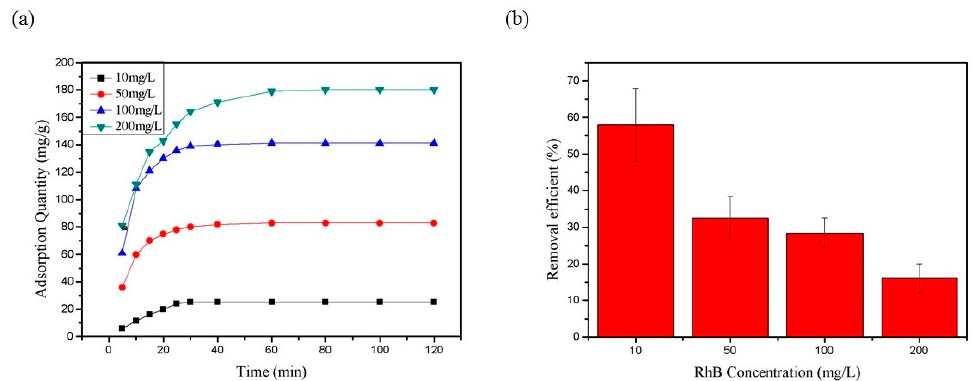
Figure 9. ( a ) Adsorption of RhB (10–200 mg/L) onto CNF Aerogel and ( b ) percentage of removal of RhB within 120 min.